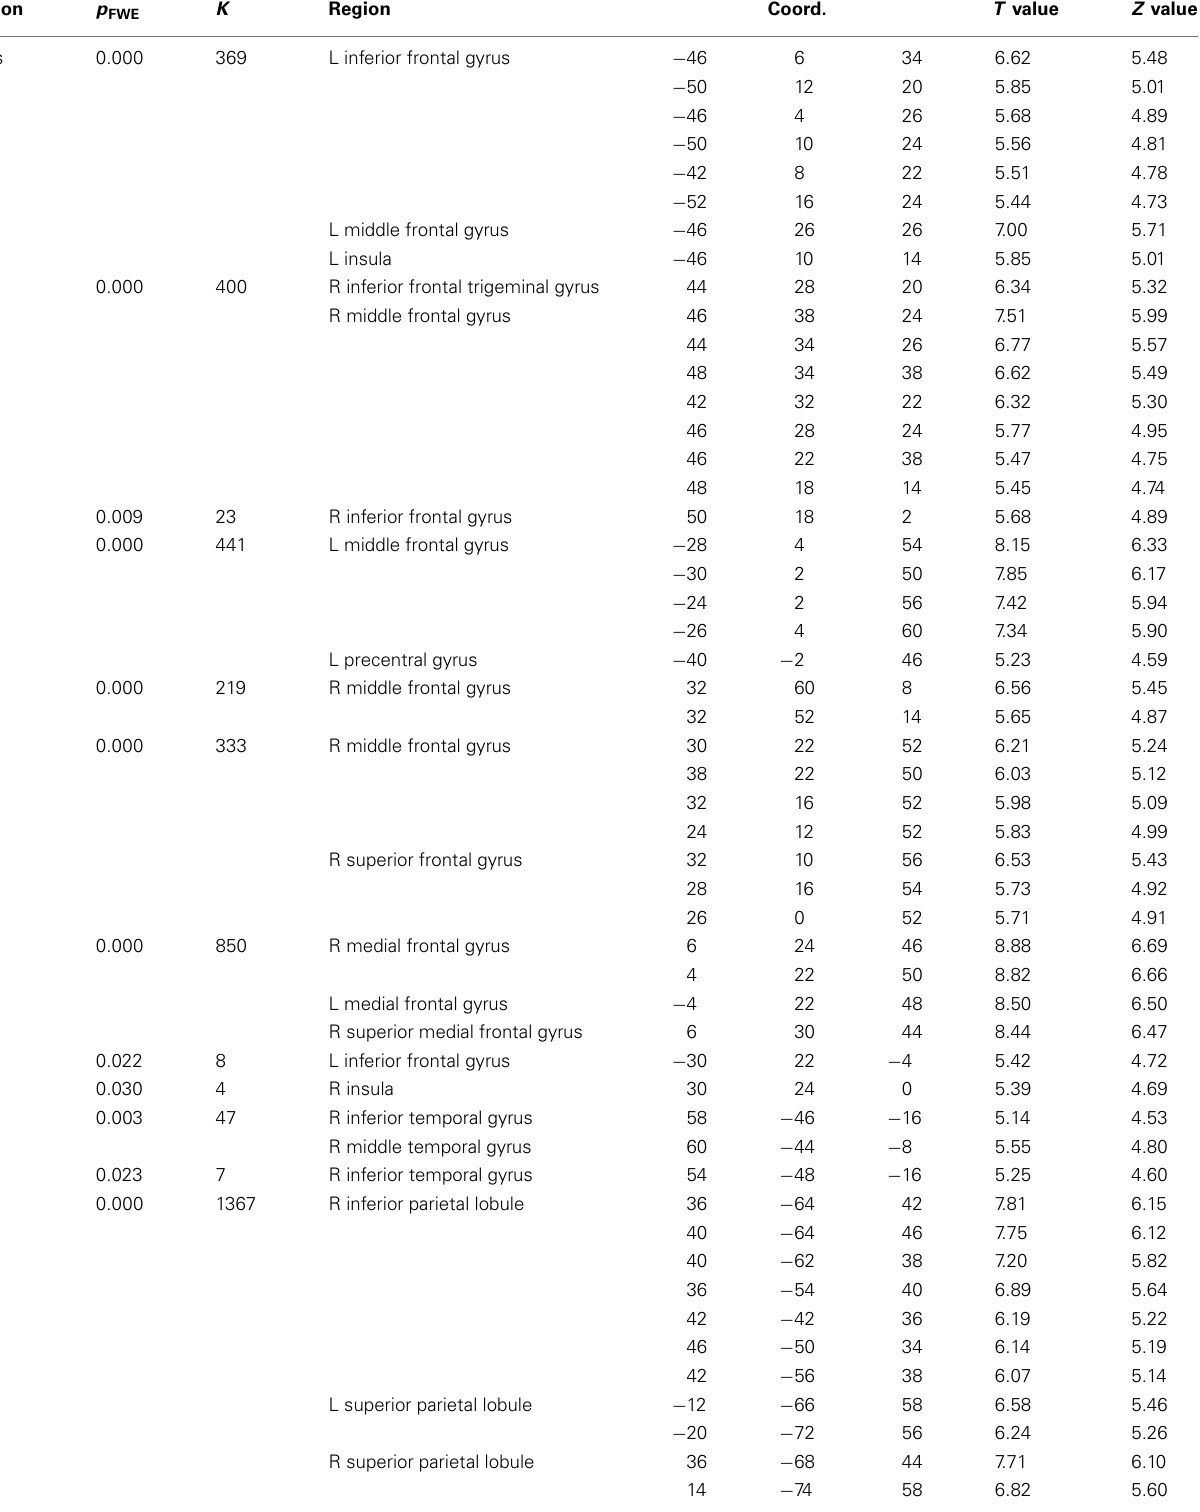
TableA1 | Significant fixed-effects for patients and controls for the 2back-0 contrast.